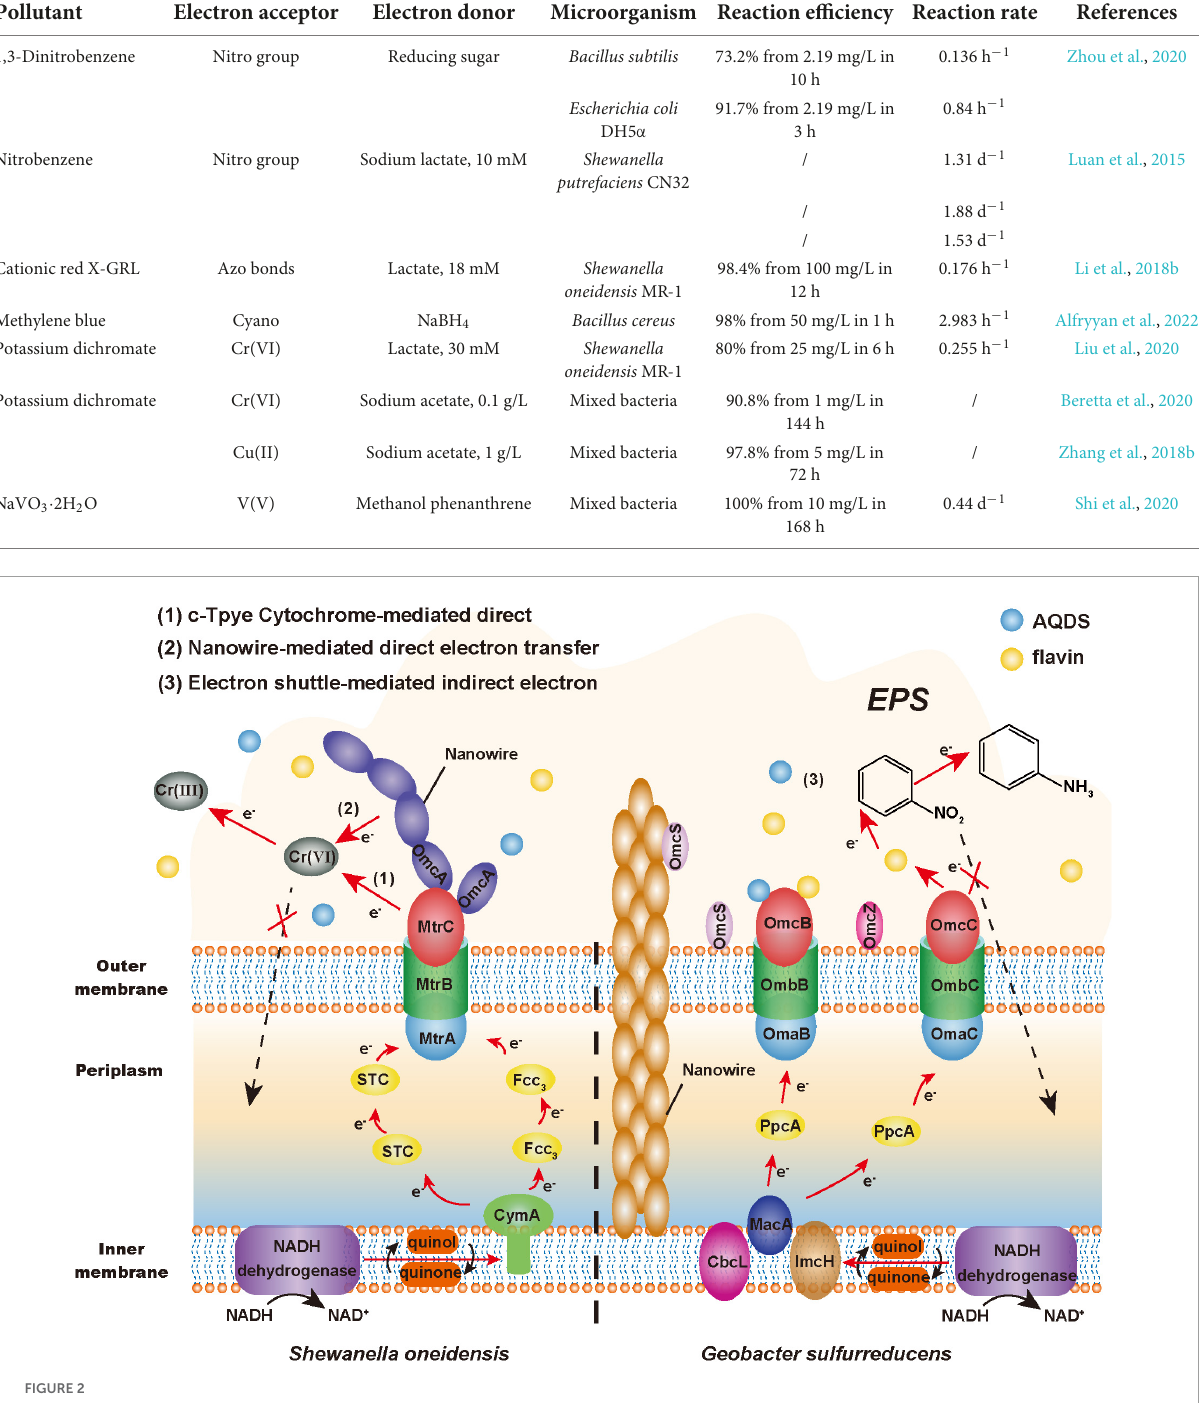
TABLE 2 A summary of toxic pollutants reduced by electroactive microorganisms. Pollutant